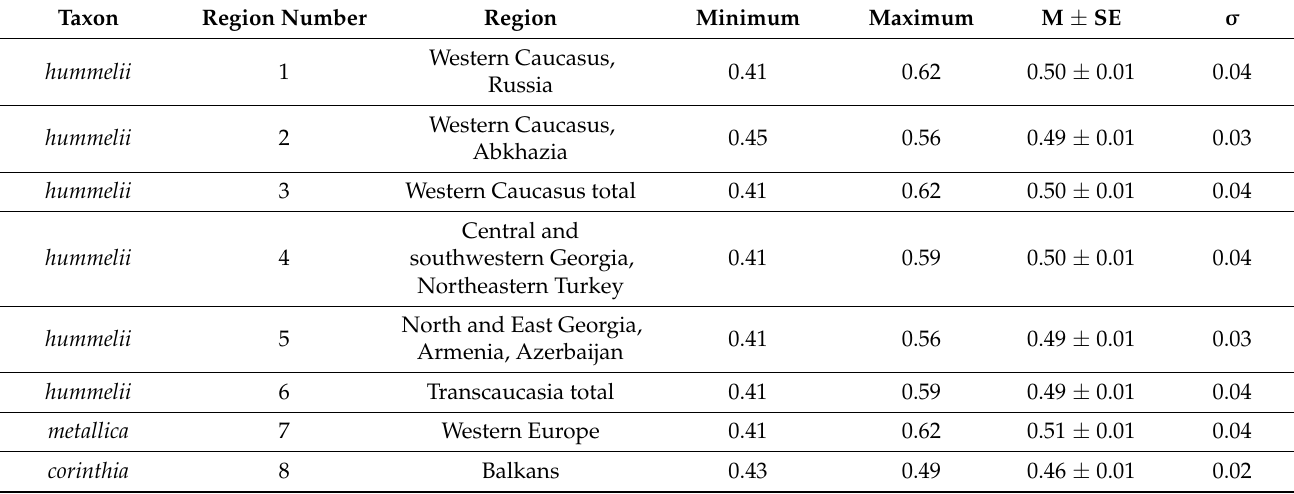
Table 4. Size of the pronotum (a): pronotal length (in dorsal view)/elytral length. M—mean value, σ —standard deviations, SE—standard